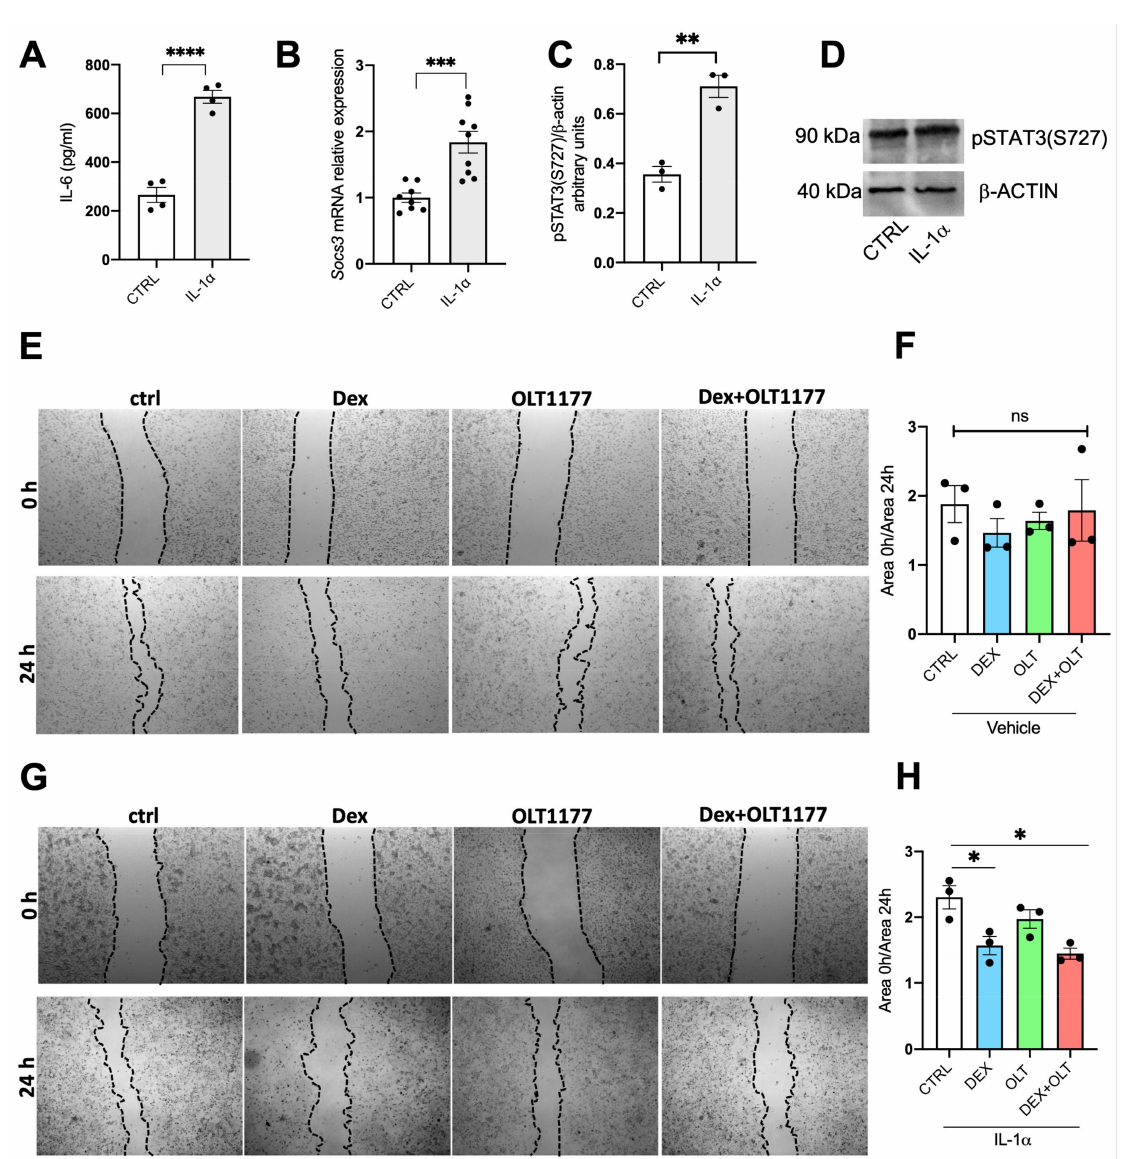
Figure 3. IL-1 β induced proliferation is reduced by OLT1177 and dexamethasone. ( A ) IL-6 levels in the supernatants of 1205Lu incubated for 24 h with human IL-1 α . ( B ) Gene expression of SOCS3 in 1205Lu cells from ( A ). ( C ) Western blot analysis of pSTAT3 (S727) in 1205Lu cells incubated for 24 h with either vehicle of human IL-1 α . ( D ) A representative Western blot performed on 1205Lu cells from cells shown in ( B ). ( E ) A representative photomicrograph of 1205Lu cells treated with vehicle, dexamethasone, OLT1177 or dexamethasone + OLT1177 at the beginning of the experiment (0 h) and after 24 h. ( F ) Quantification of the growth area measured as the ratio between the scratched area at the beginning of the experiment and at the end. ( G ) A representative photomicrograph of 1205Lu cells stimulated with human IL-1 α and then treated with vehicle, dexamethasone, OLT1177 or dexamethasone plus OLT1177 at the beginning of the experiment (0 h) and at the end (24 h). ( H ) Quantification of the growth area measured as the ratio between the scratched area at the beginning of the experiment and at the end. Data are presented as mean ± SEM. * p < 0.05; ** p <